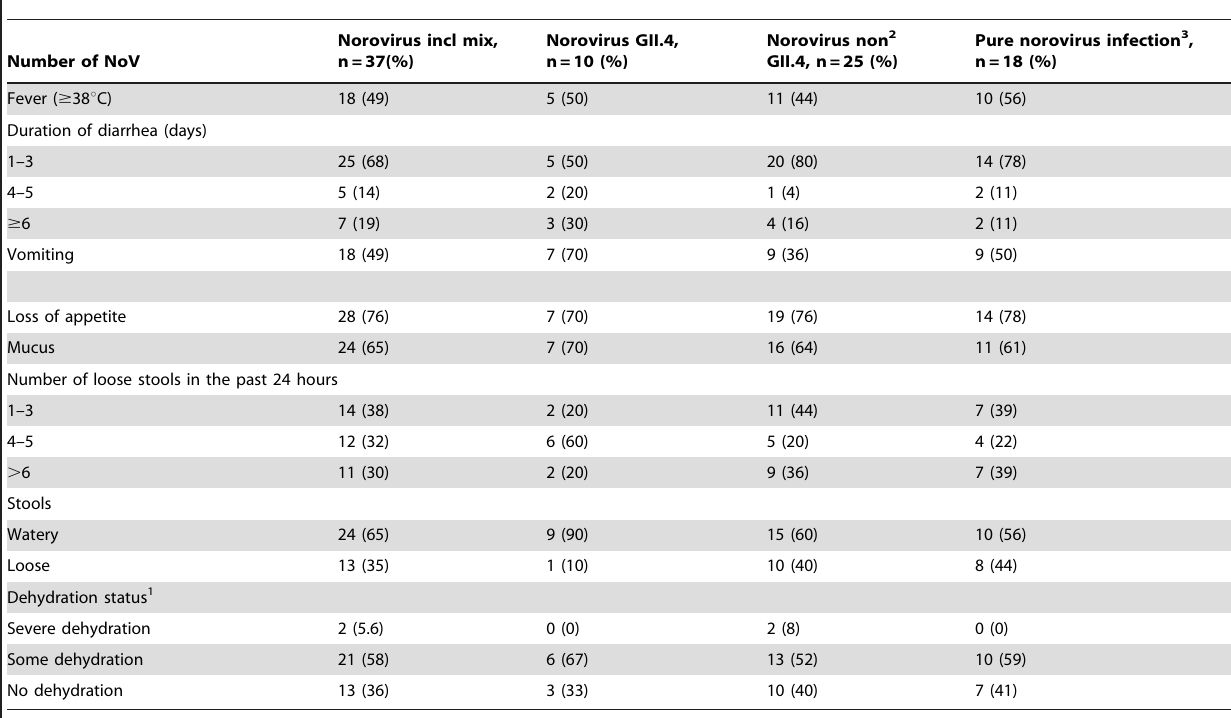
Table 1. Clinical features of NoV-infected children with and without concomitant infections.